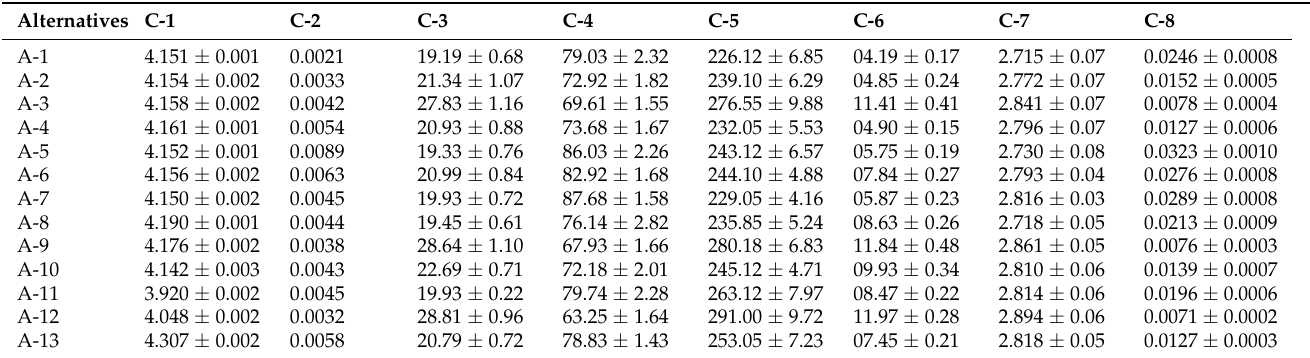
Table 2. Experimental